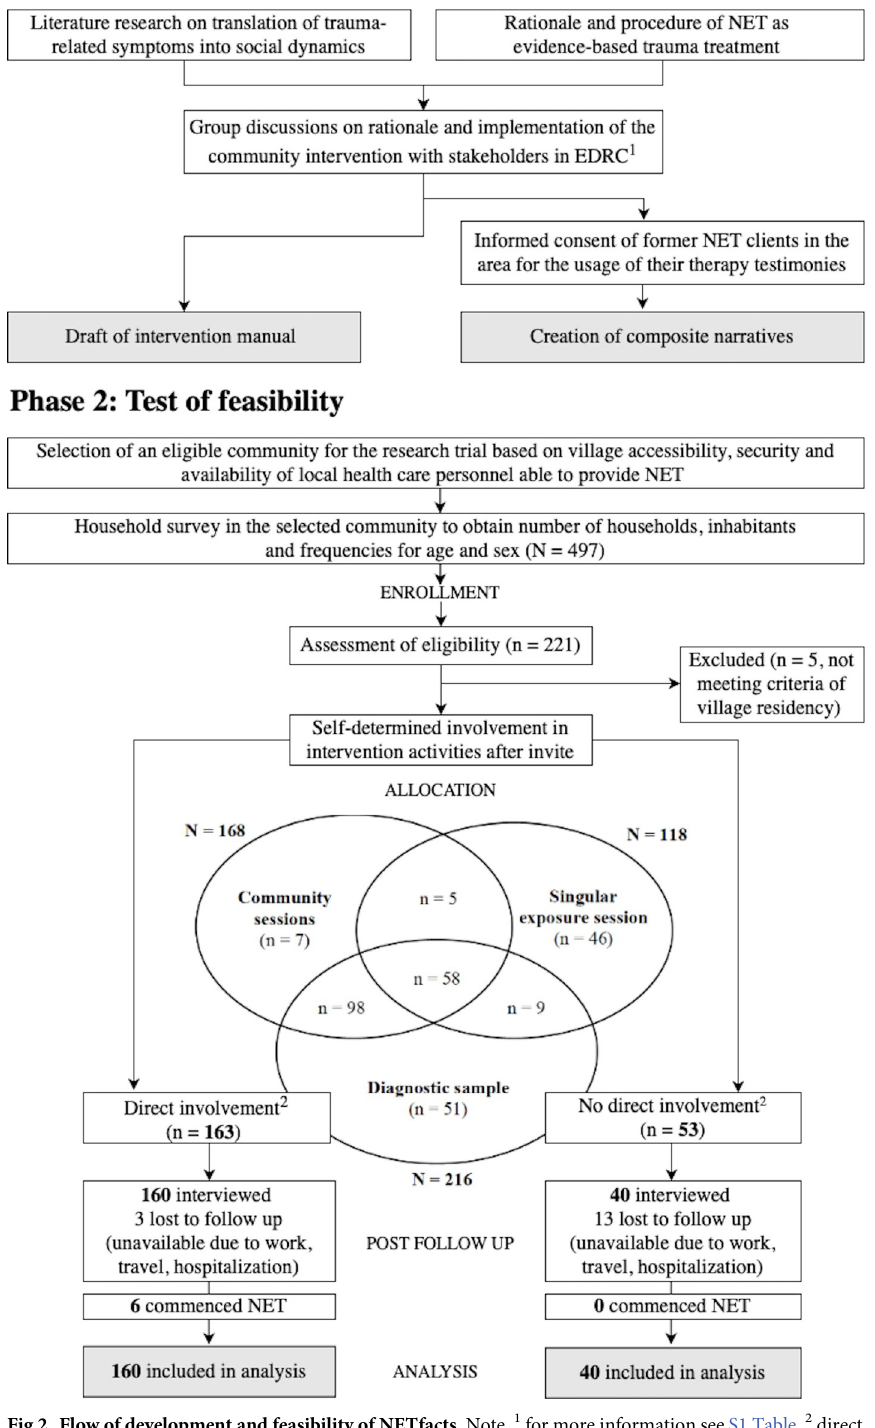
PLOS ONE | https://doi.org/10.1371/journal.pone.0275421 December19, 2022 6 /